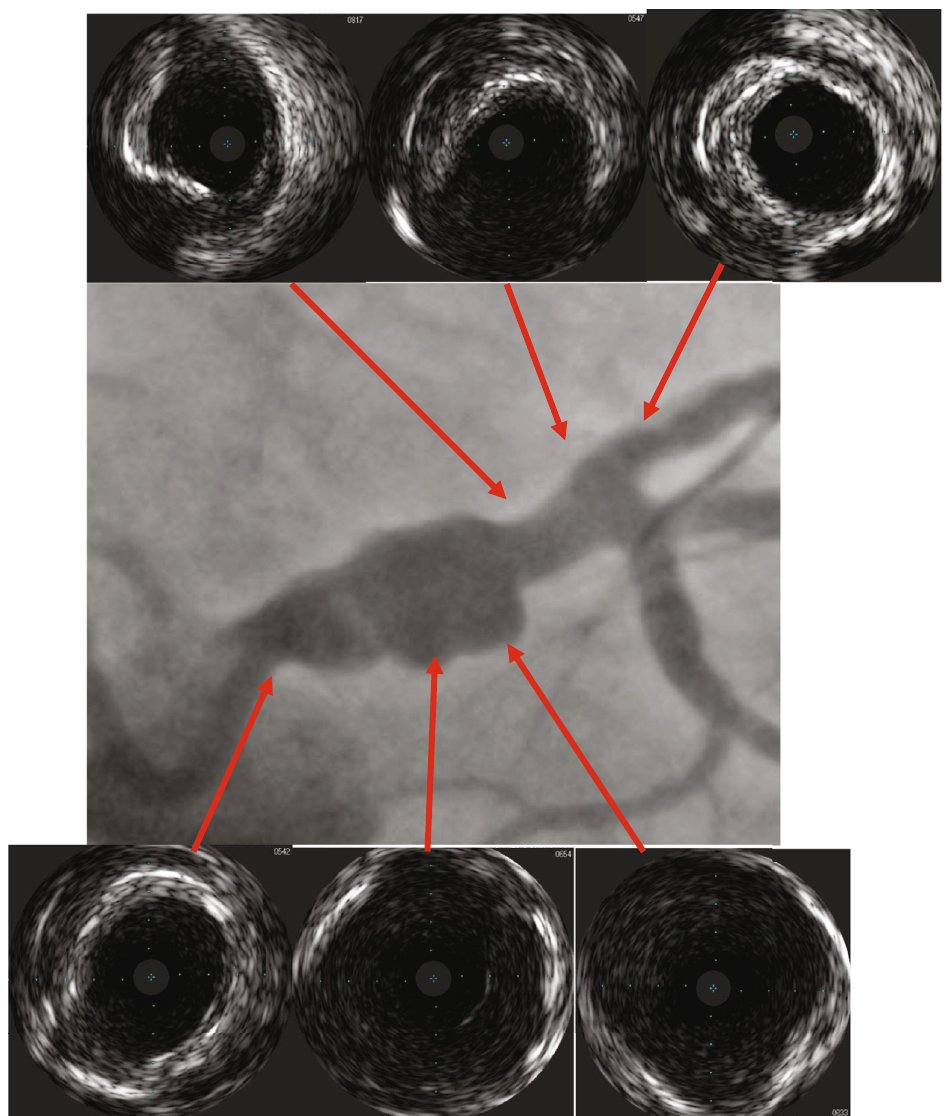
Figure 5: Baseline IVUS shows the aneurysm diameter and length. Healthy ostial and distal end of the left main coronary artery. Maximum diameter at aneurysm 10.6mm, healthy segment